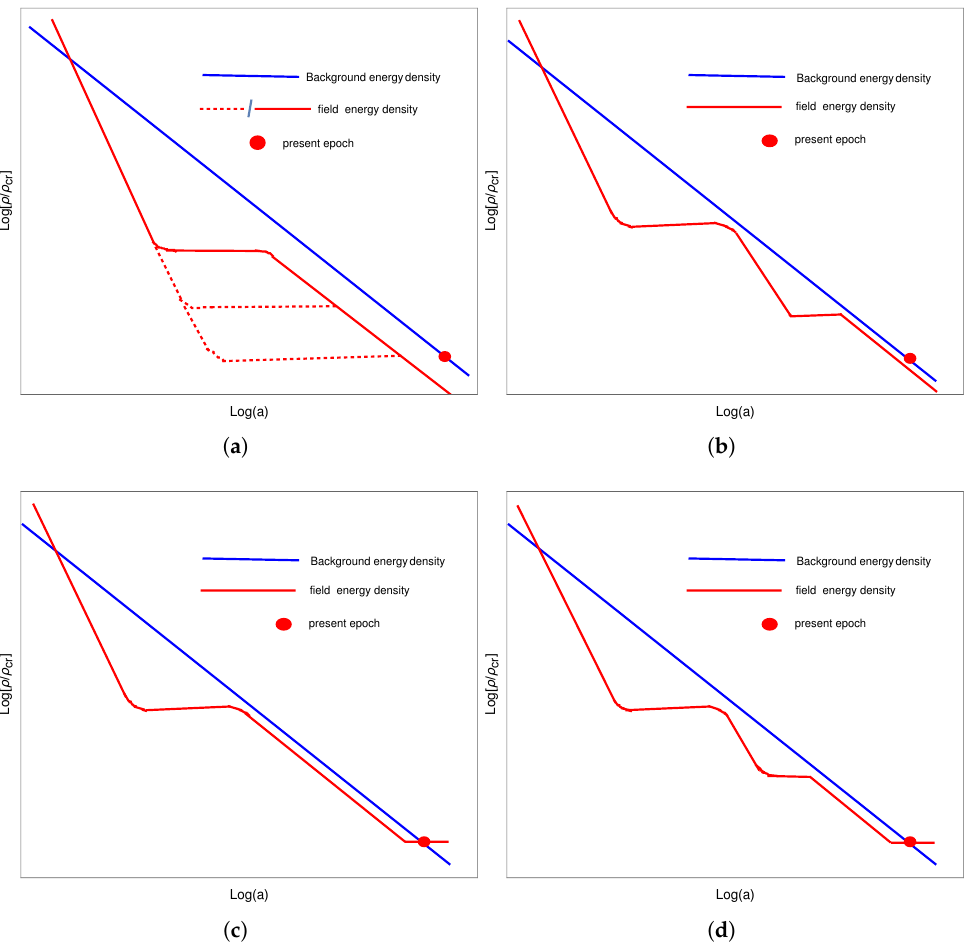
Figure 4. Figure shows the qualitative behaviour of ρ φ along with the energy density of background matter (cold matter/radiation) versus ln a for a steep potential. As ρ φ overshoots the background energy density ( ρ φ (cid:28) ρ b ρ b designates background matter energy density), the field freezes on its potential due to Hubble damping. After the recovery from freezing, field evolution crucially depends upon the nature of the steepness of the potential. ( a ) In case of the exponential potential ( Γ = 1), the field catches up with the background and tracks it forever. ( b ) exhibits the general feature of scalar field dynamics for a field potential steeper than the exponential potential ( Γ < 1): after recovery from freezing, ρ φ evolves in steps (down and right) and eventually catches up with the background [130]—asymptotic scaling solution. ( c , d ) show exit from scaling and asymptotic scaling regimes to late time acceleration at the present epoch ˆa la a perfect tracker . Exit is triggered due a late time feature in the runaway potential that makes it shallow at late stages of